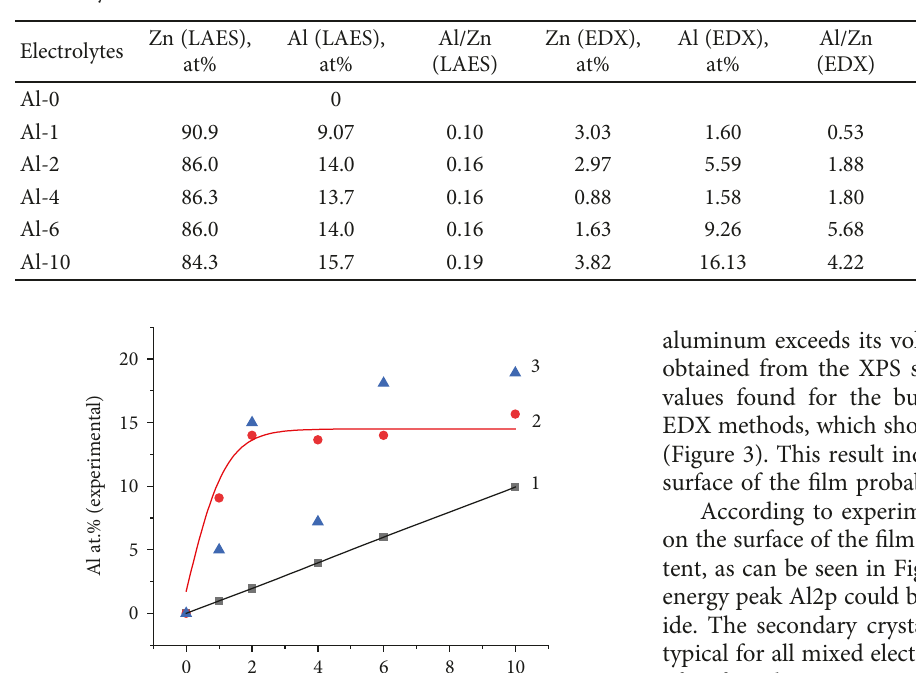
Figure 2: Characteristic XPS bands for Al 2p and O 1s for the sample with theoretical percentage of Al 2 at.%. Table 2: Characteristics of ZnO:Al coatings after annealing at 530 ° C for 1 hours. 1 μ m thick fi lms have been applied for LAES, EDX, and XPS analyses.